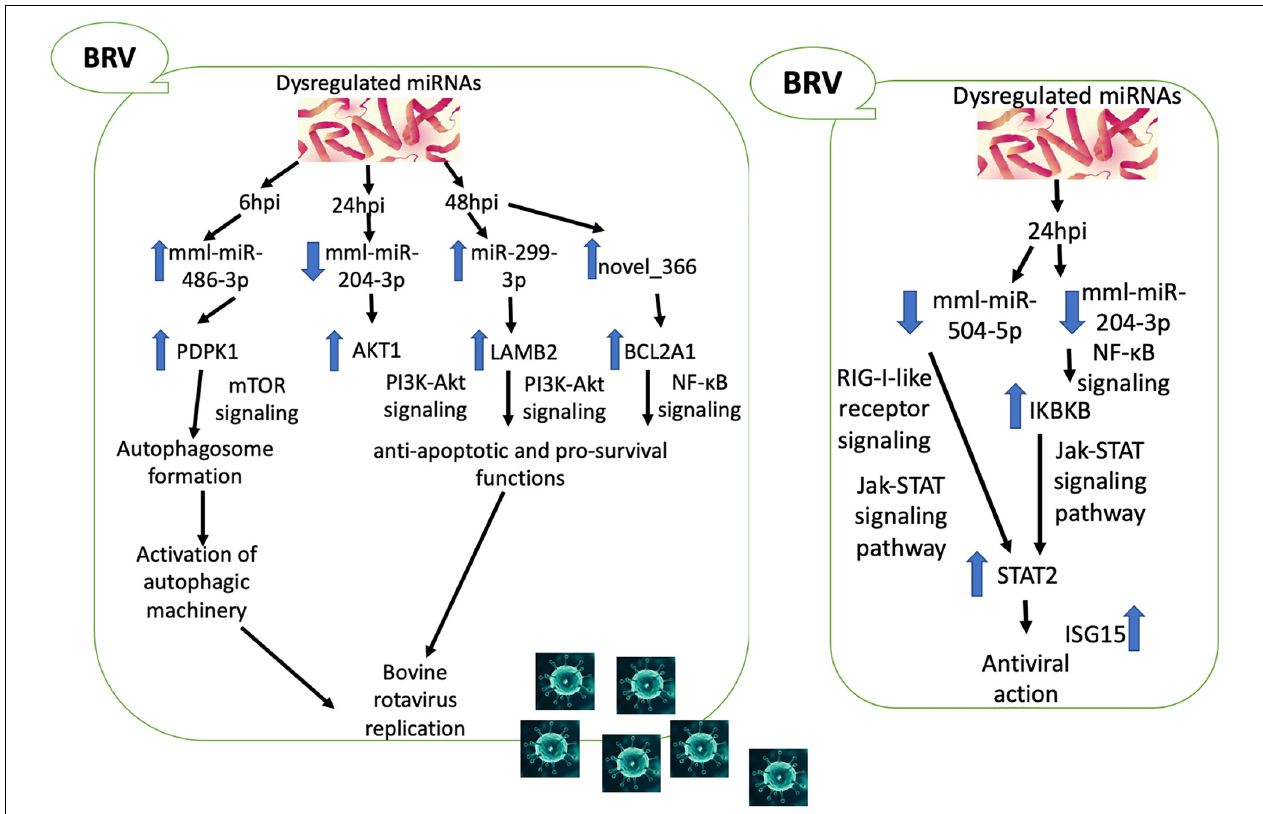
FIGURE 10 | Predicted crosstalk between the differentially expressed (DE) microRNAs (miRNAs), target messenger RNAs (mRNAs), and the signaling pathways during bovine rotavirus (BRV) infection.